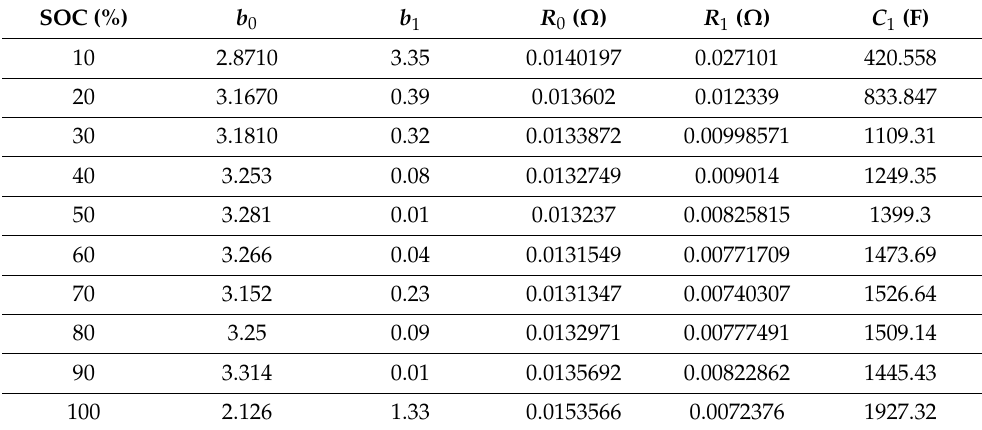
Table 9. Battery parameters in all points of SOC.